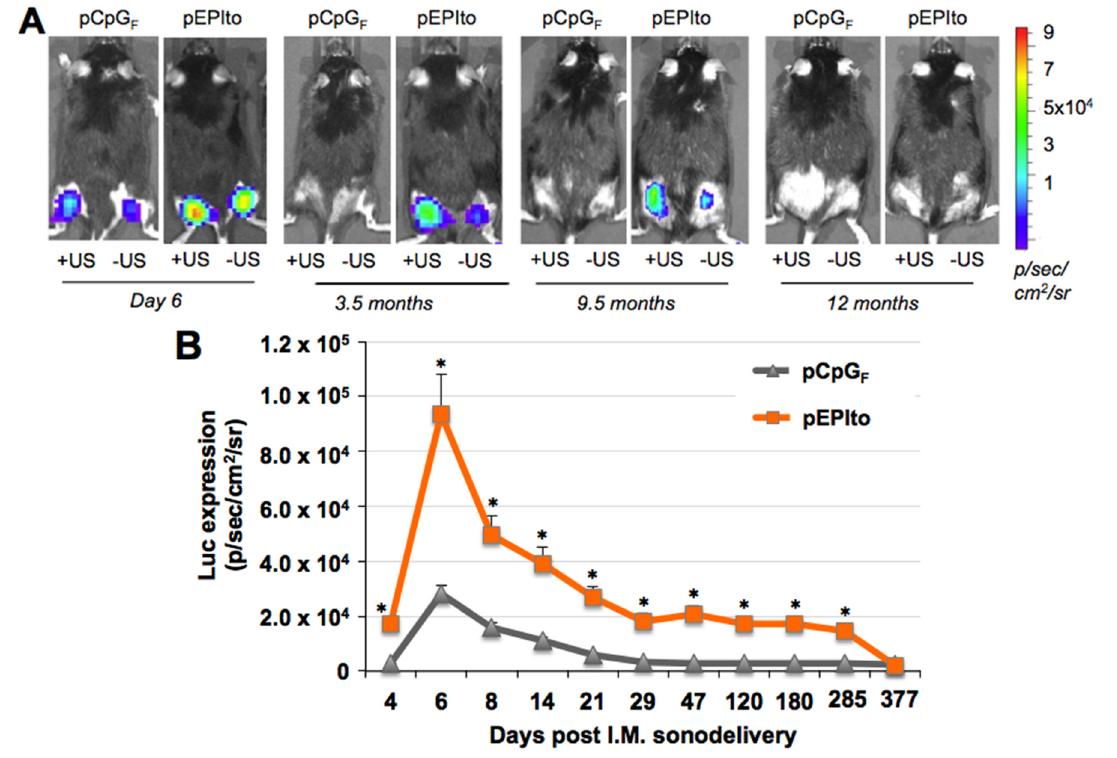
Figure 2. ( A ) Sonodelivery of pEPIto-Luc in vivo ; ( B ) Quantification of